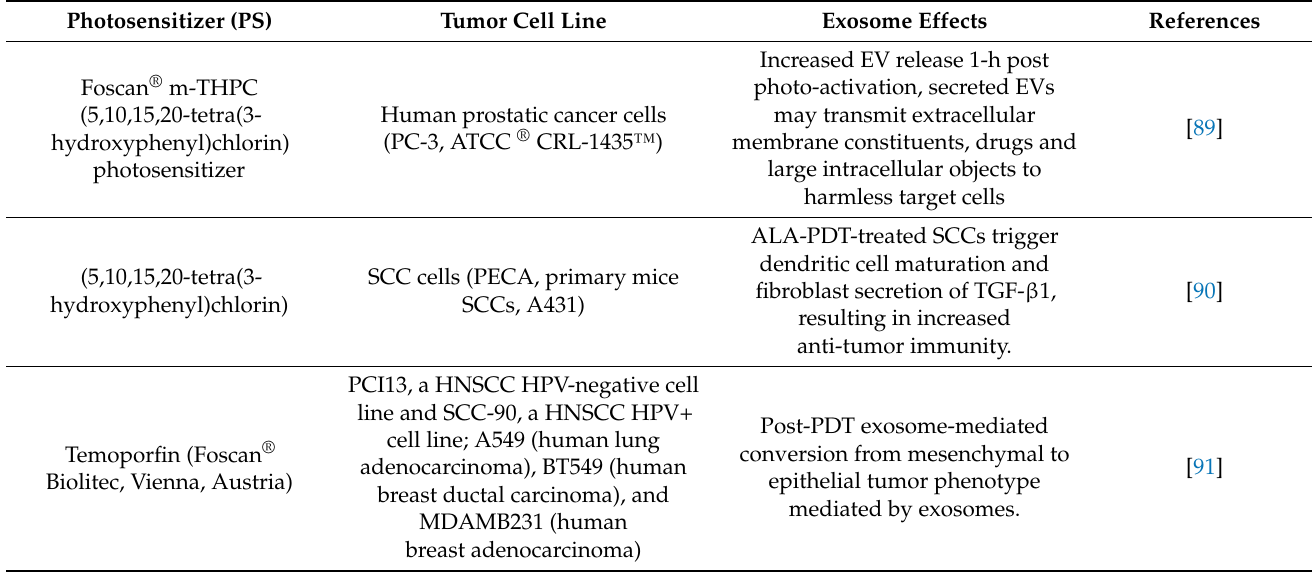
Table 2. Effects of exosome induced by various photodynamic therapy on different tumor cell lines, using different photosensitizers. Photosensitizer (PS)